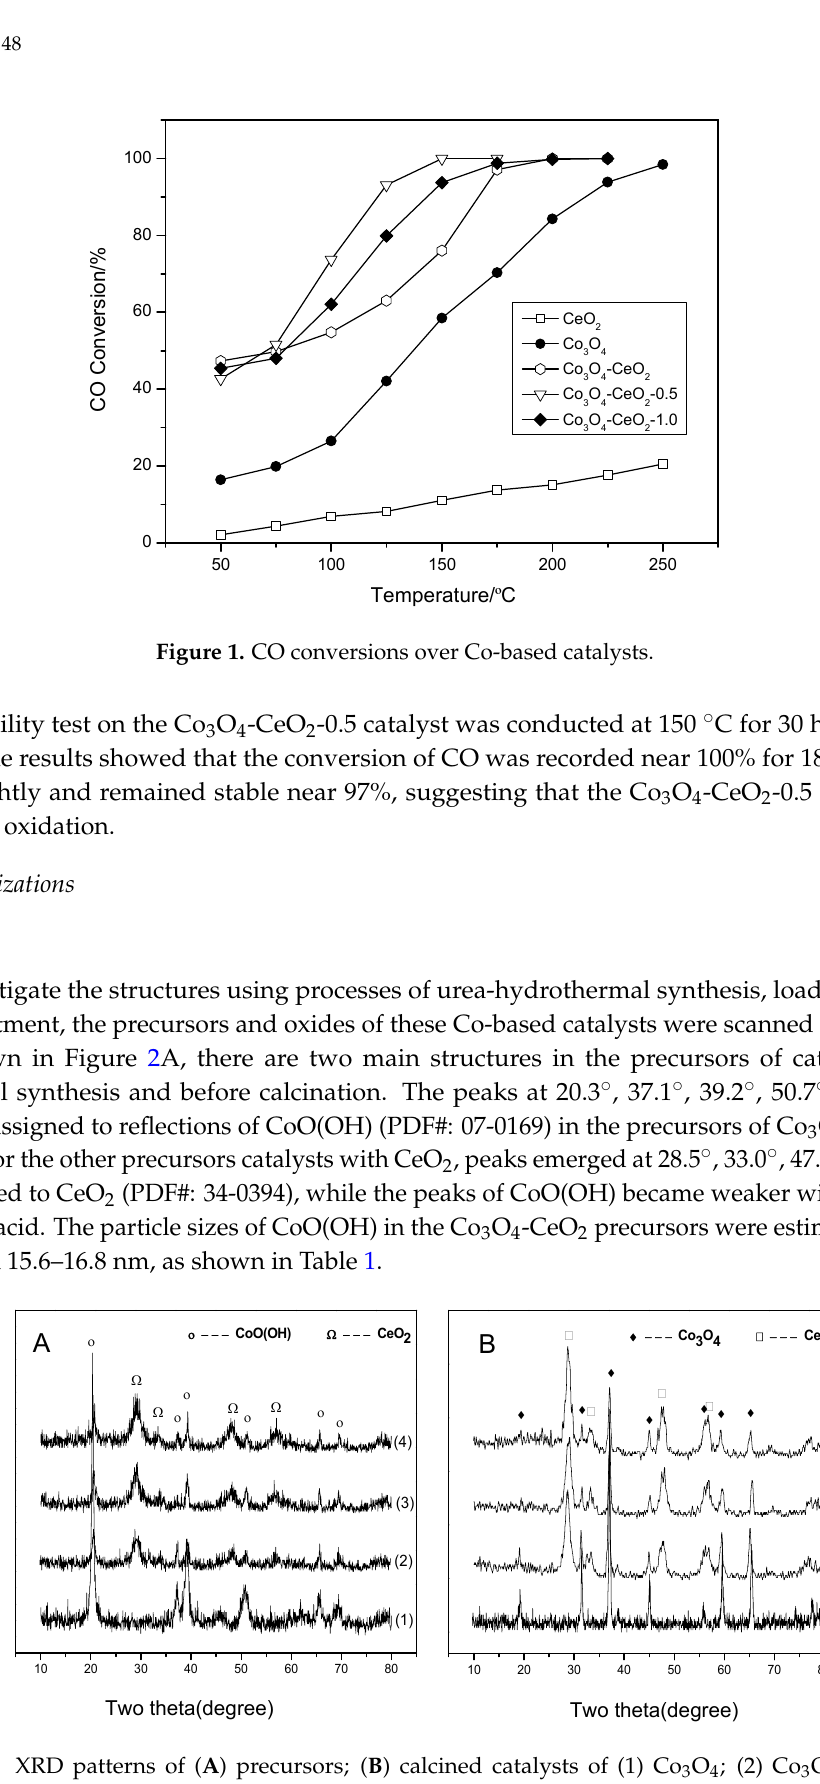
Figure 2. XRD patterns of ( A ) precursors; ( B ) calcined catalysts of (1) Co 3 O 4 ; (2) Co 3 O 4 ‐ CeO 2 ; (3) Co 3 O 4 ‐ CeO 2 ‐ 0.5; and (4) Co 3 O 4 ‐ CeO 2 ‐ 1.0.